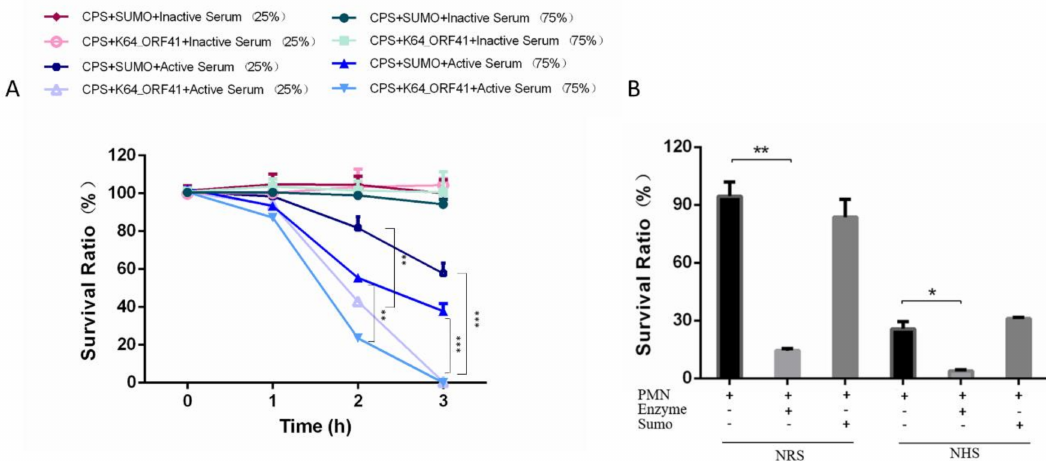
Figure 6. Effect of the K64-ORF41 on bacterial susceptibility to serum killing and neutrophil killing. ( A ) K. pneumoniae strain Y8 pretreated with K64-ORF41 were incubated with 75% or 25% normal human serum (NHS) or heat-inactivated serum for 1 h, 2 h, and 3 h at 37 ◦ C, and SUMO protein was served as control. ( B ) K. pneumoniae strain Y8 was cultured with human neutrophils with or without the enzyme (K64-ORF41) as indicated. Neutrophils were pre-mixed with 5% normal rabbit serum (NRS) or 5% normal human serum (NHS). SUMO protein was served as control. The survival ratio of bacteria was determined based on viable counts with respect to the initial inoculum. Results were represented by the survival ratio from three separate experiments (mean ± SD). Significance was determined by Student’s t test (*, p < 0.05; **, p < 0.01; ***, p <